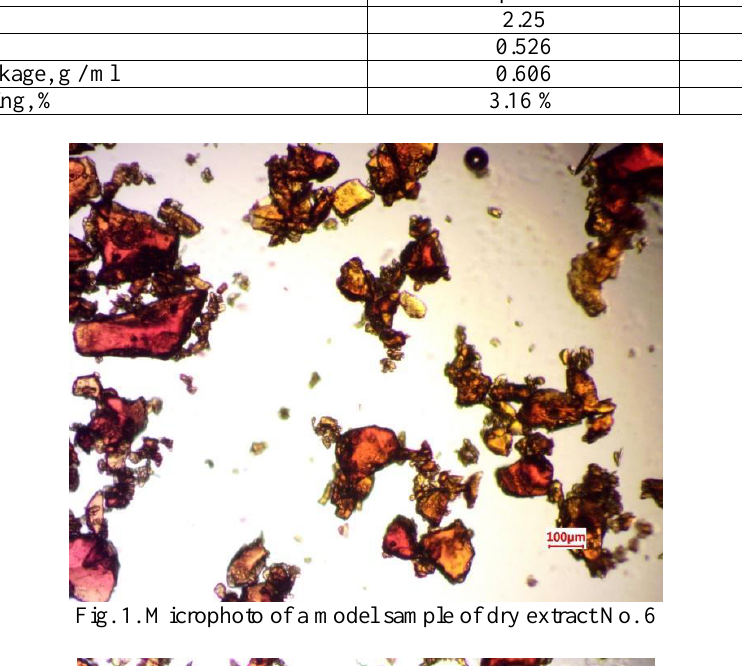
Fig. 1. Microphoto of a model sample of dry extract No. 6